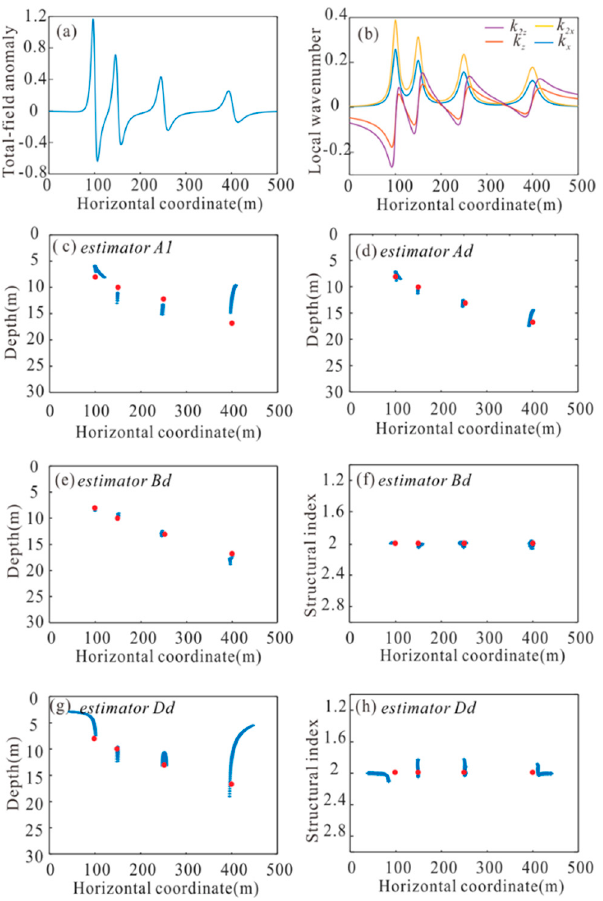
Figure 6. ( a ) Magnetic anomaly of four cylinders having a magnetization inclined at 60°; ( b ) first- and second-order local wavenumbers of magnetic anomaly in Figure 5a; ( c ) source location results generated by estimator A1; ( d ) source location results generated by estimator Ad; ( e ) source location results generated by estimator Bd; ( f ) structural index results generated by estimator Bd; ( g ) source location results generated by estimator Dd; ( h ) structural index results generated by estimator Dd.